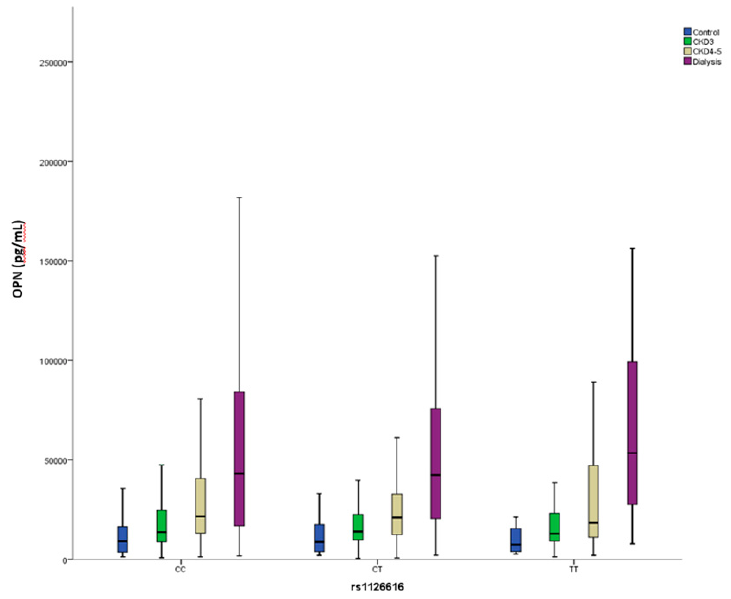
Figure 3. Circulating Osteopontin (OPN) levels stratified according to rs1126616 genotype and chronic kidney disease stage. Table 3. Association of SPP1 rs1126616 C > T polymorphism with epidemiological, clinical and biochemical parameters of the cohort.